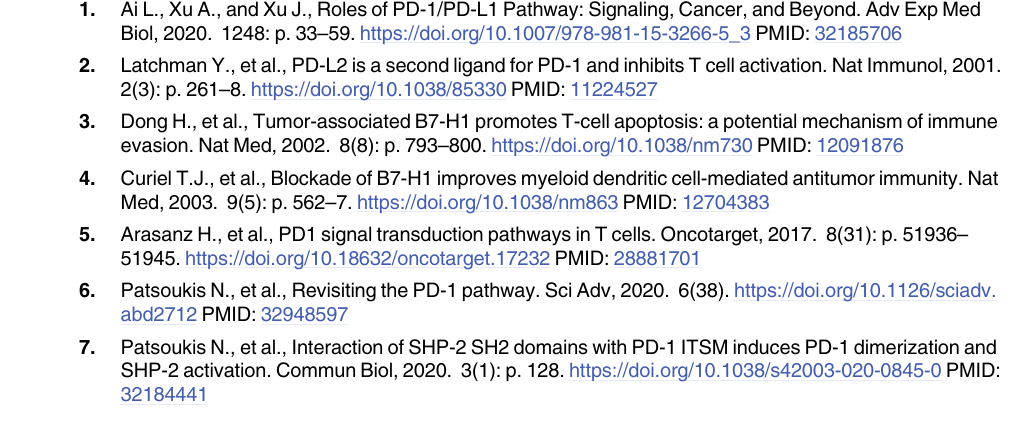
S2 Fig. MC-38 in vivo model. (PPTX) S3 Fig. NCI-H292/hPBMC co-mixture model. (PPTX) S4 Fig. HLX10 and PD-1 contact. (PPTX) S1 File. Supplemental material and